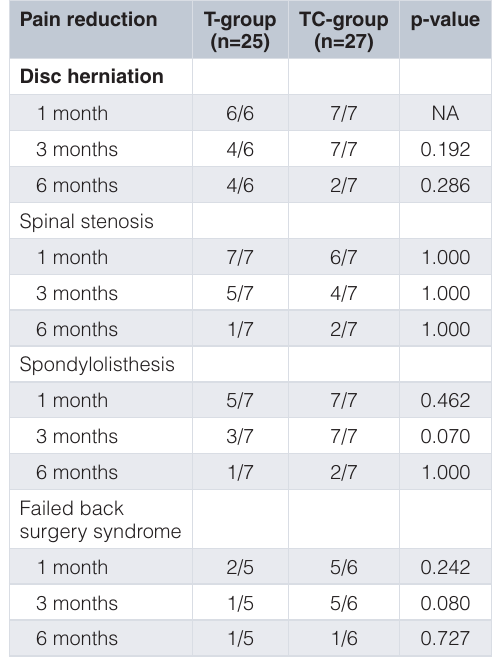
Table 3. The number of patients with a decrease in VNRS of 30% or greater from baseline at each follow-up period classified by